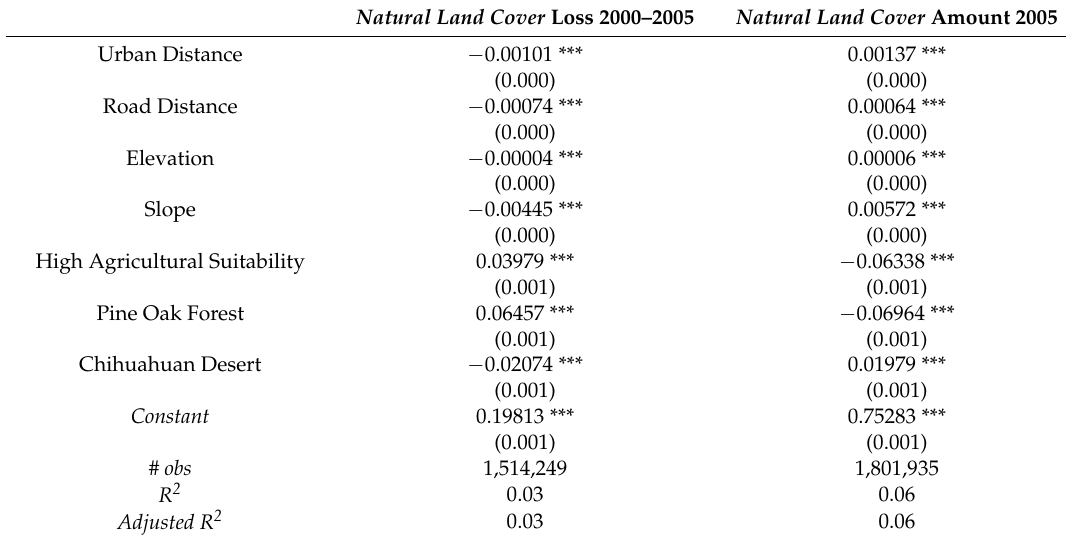
Table 3. Drivers of natural land cover, explaining both loss & final amount (outside